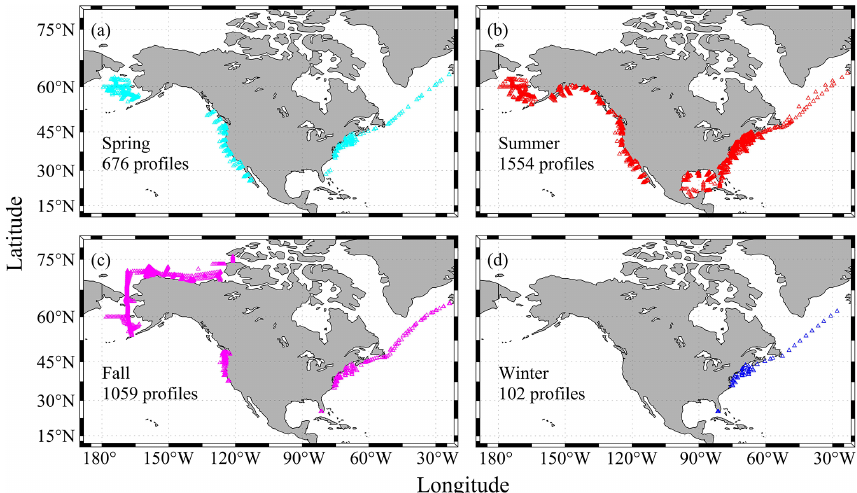
Figure 5. Sampling profiles in each of the four seasons: (a) spring (March–May), (b) summer (June–August), (c) fall (September– November), and (d) winter